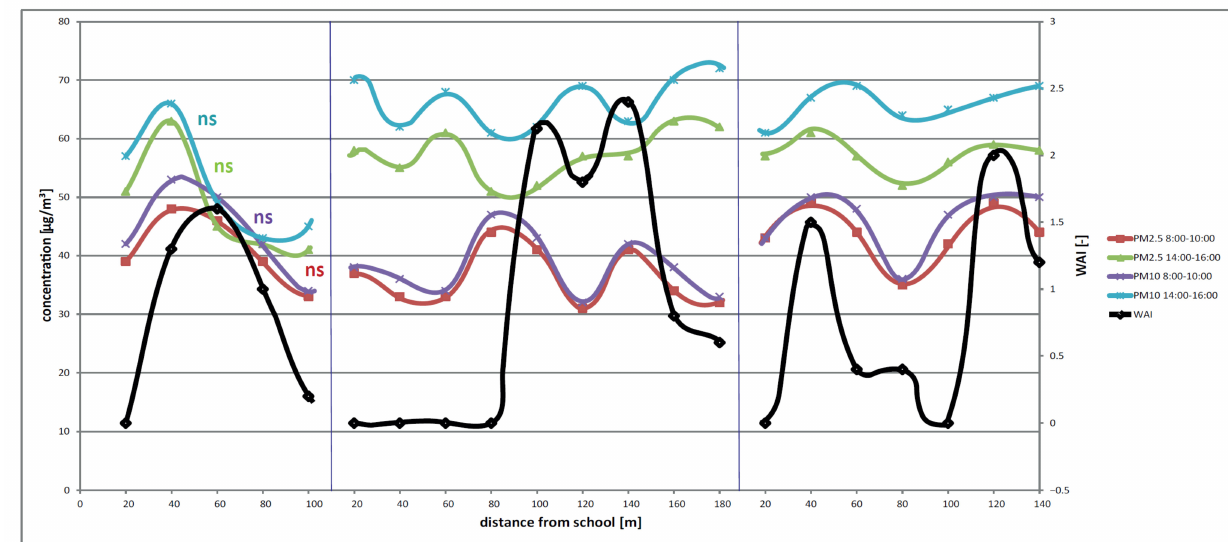
Figure 6. WAI distribution and an average PM concentration from 8:00 to 10:00 and from 14:00 to 16:00 in study plots along walking paths to school C (very high share of trees, low number of local heating emission sources). ns—no significance.